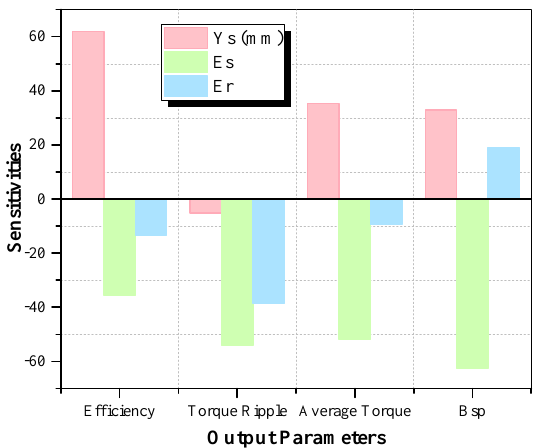
Figure 9. Sensitivity Chart. It is used to identify key variables impacting performance metrics, and the quantitative nature of their impact,